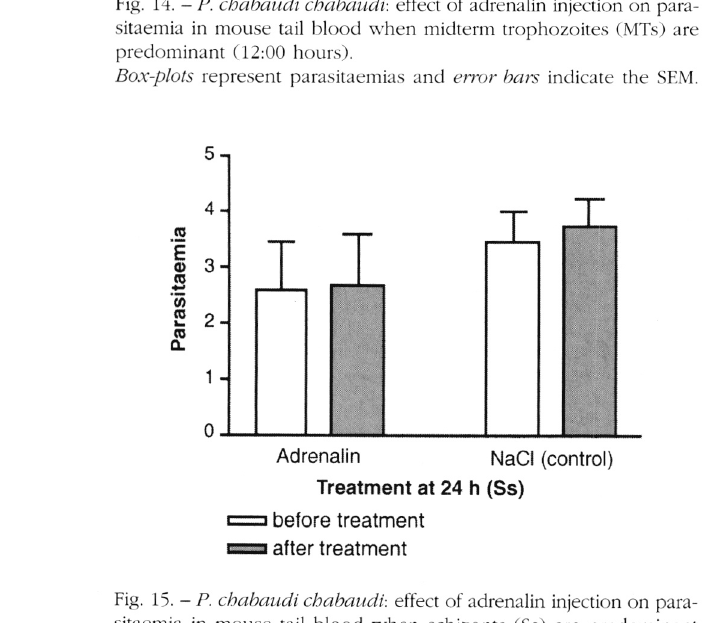
14. - P. chabaudi chabaudi: effect of adrenalin injection on para­ sitaemia in mouse tail blood when midterm trophozoites (MTs) are predominant (12:00 hours). Box-plots represent parasitaemias and error bars indicate the